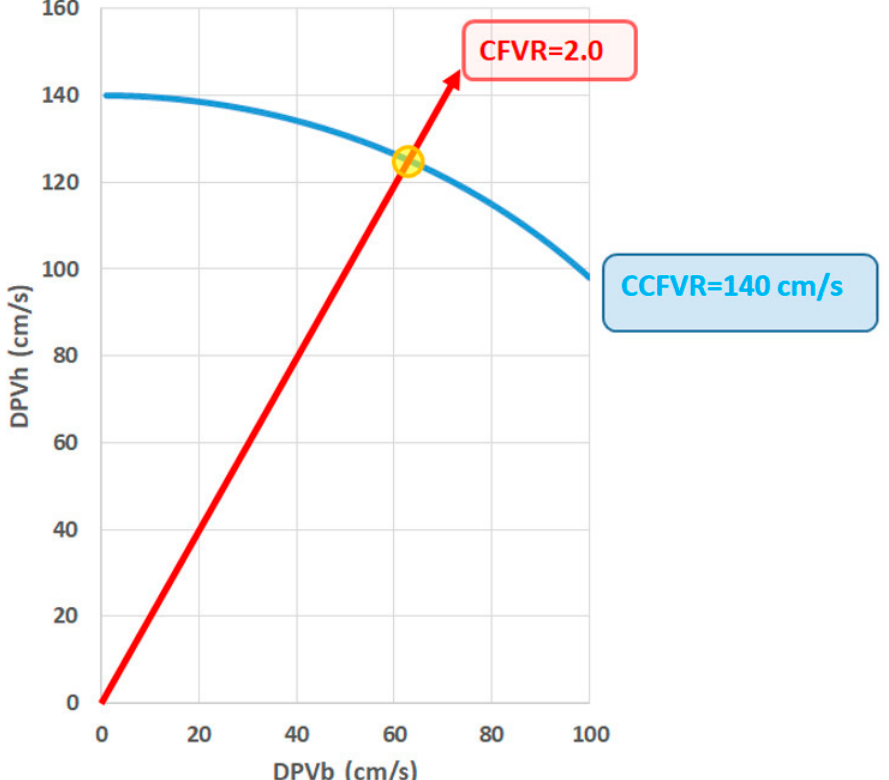
Figure 2. Coronary flow velocity domain representation, showing diastolic peak velocity during hyperemia (DPVh) versus diastolic peak velocity during baseline (DPVb). The traditional index refers to coronary flow velocity reserve (CFVR), defined as the ratio of DPVh and DPVb. The red line is an example of cases for which CFVR equals 2.0, and illustrates that any particular value is not unique. A second metric (indicated by the blue curve where CCFVR = 140 cm/s) is required to fully characterize the situation for an individual patient. The yellow marked point refers to the intersection of the line and the curve, corresponding with the combination DPVb = 62.61 cm/s and DPVh = 125.22 cm/s.